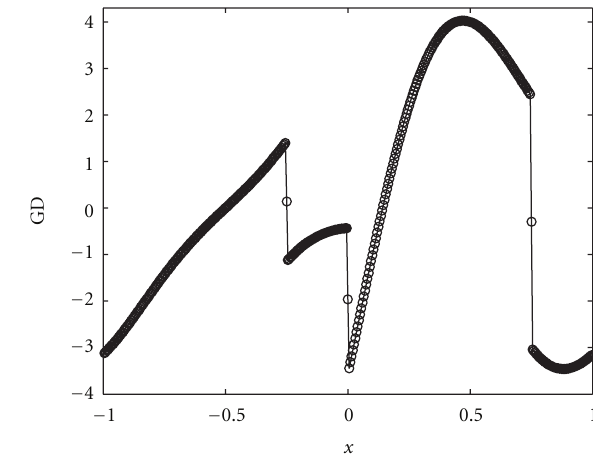
Figure 9: The graph of GD of Example 4.